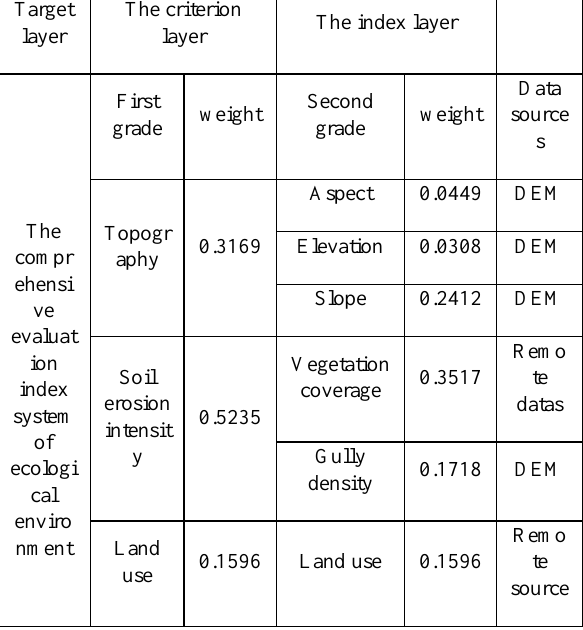
table 1 The weight of comprehensive evaluation of ecological environment